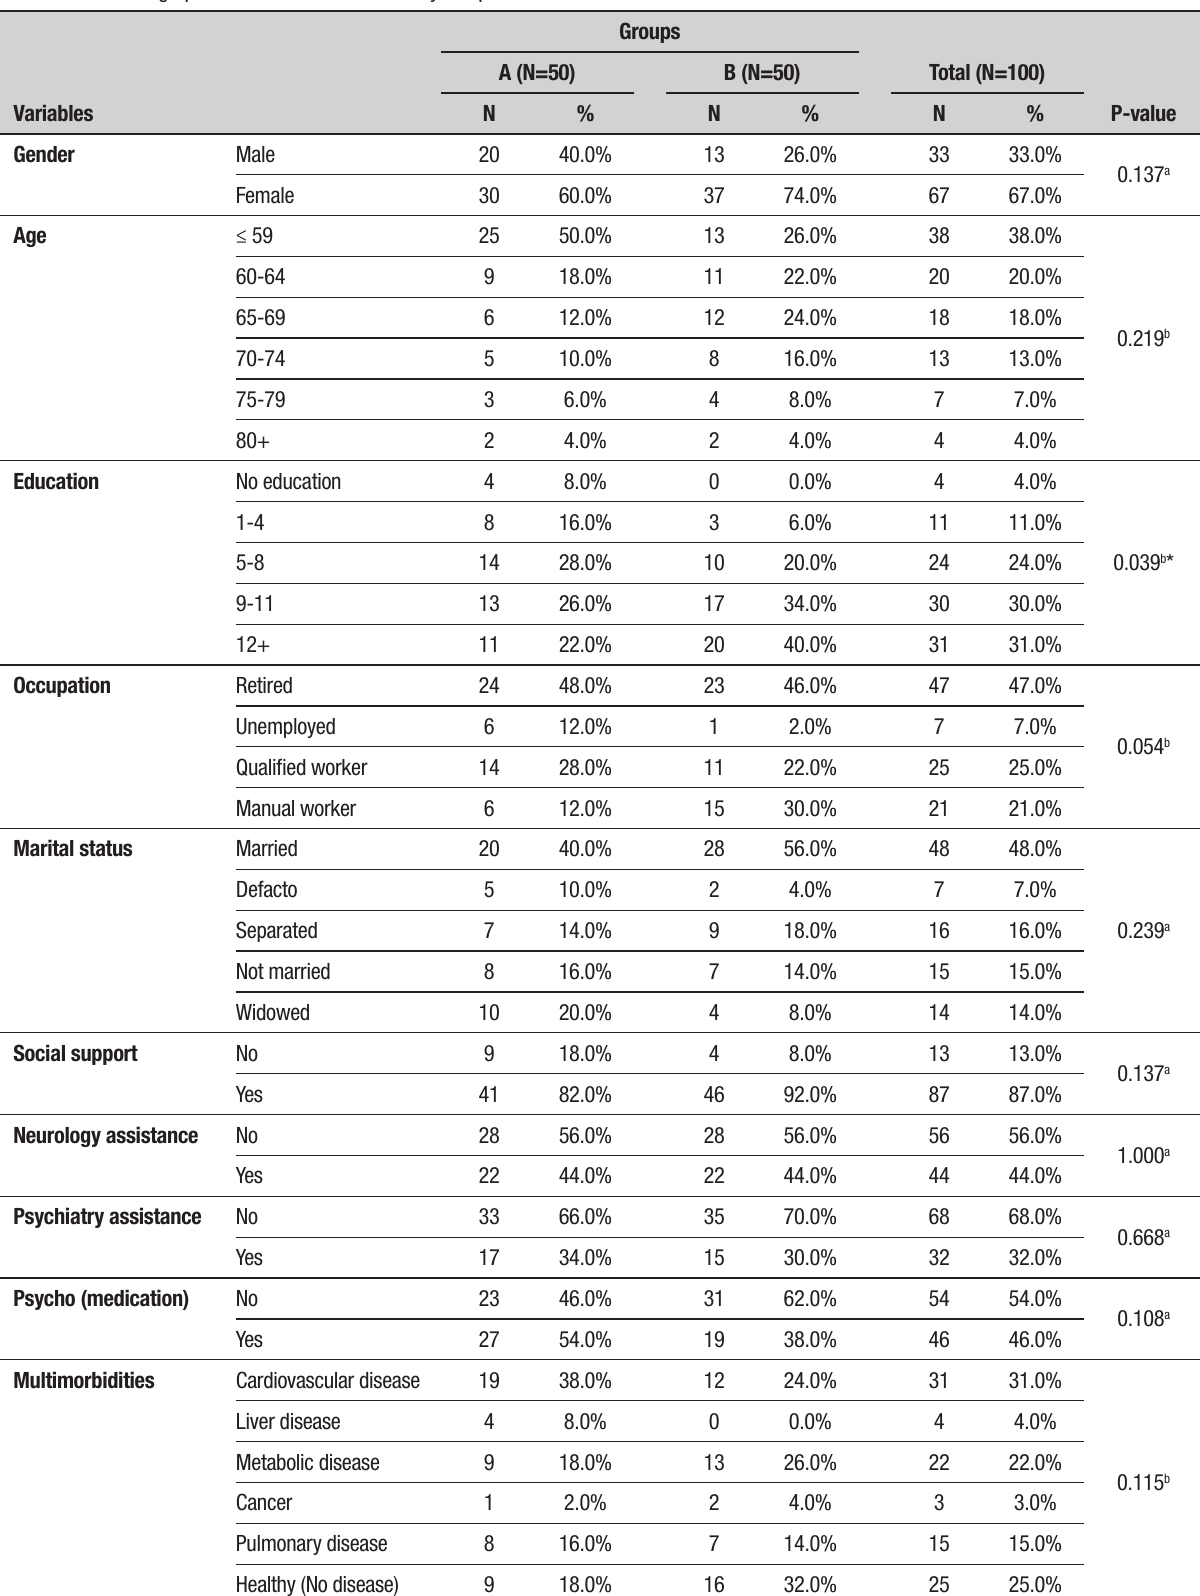
Table 1. Sociodemographic characteristics of the study samples.